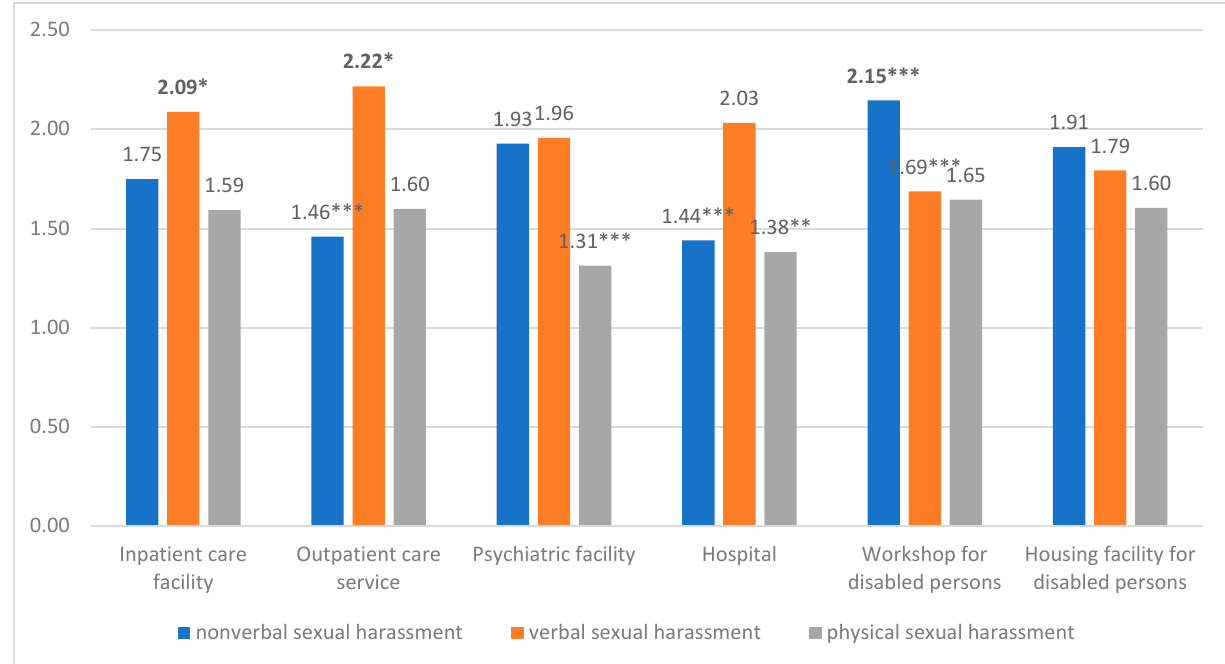
Figure 1. Comparison of the mean values of sexual harassment across the healthcare and social services sectors. Note: N = 901. Mean values that are greater than the mean value of the group of other sectors are marked in bold. Sexual harassment of social and healthcare workers by patients, clients, or residents is depicted. * p < 0.05, ** p < 0.01, *** p < 0.001.